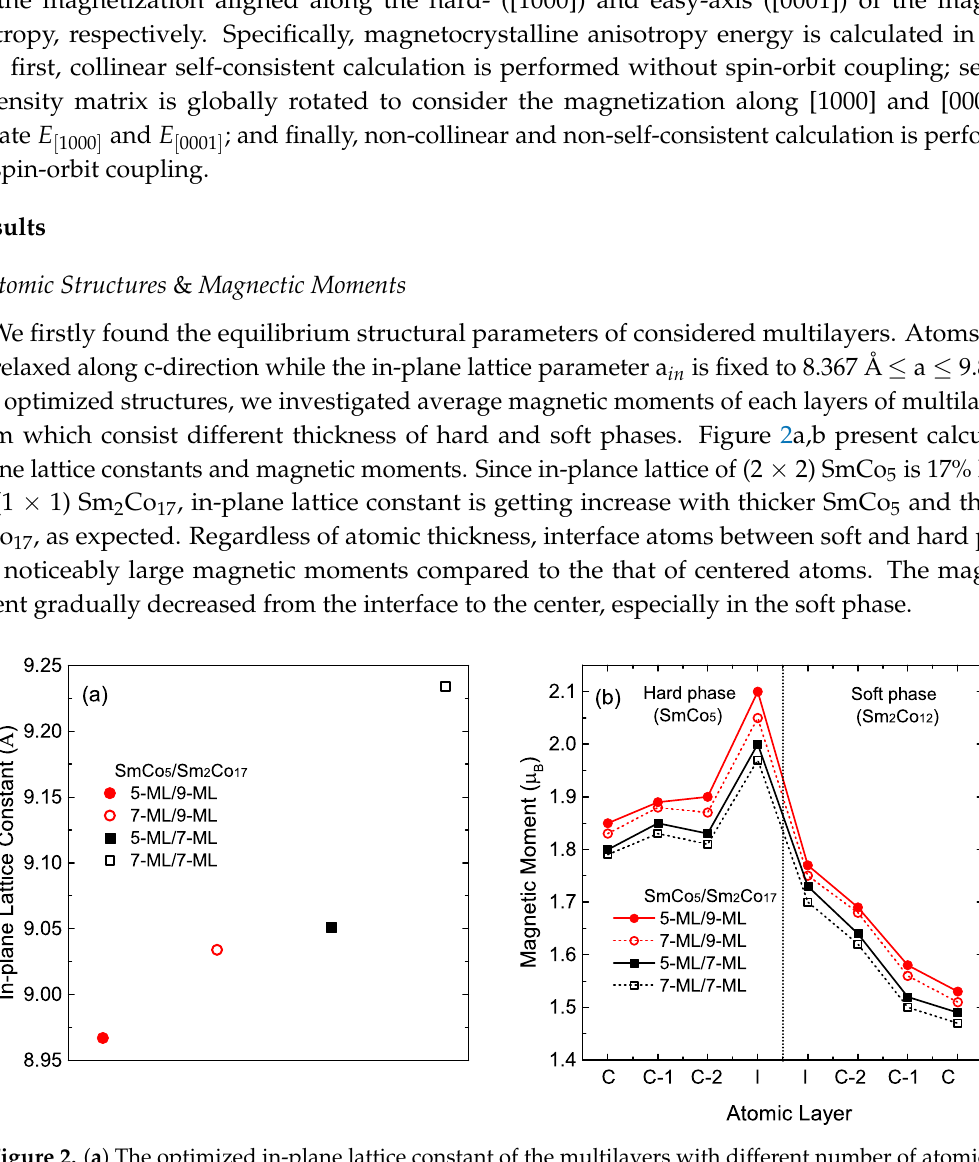
Figure 2. ( a ) The optimized in-plane lattice constant of the multilayers with different number of atomic monolayer (ML); ( b ) Calculated average magnetic moment of Co atoms with respect to the atomic layer. While C and C-n denote the centered layer and the n layer below the center, respectively, I denotes the interface between SmCo 5 and Sm 2 Co 17